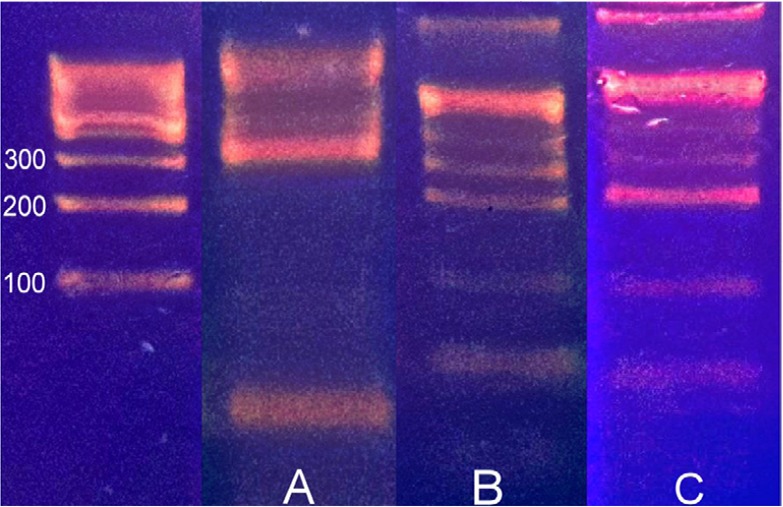
This figure shows the bands of each Growth Differentiation Factor 5 genotype in the electrophoresis gel: A represents TT (fragment length 344 bp), B represents TC (fragment length 104, 230, and 344) and C represents CC (fragment length 104, 230).